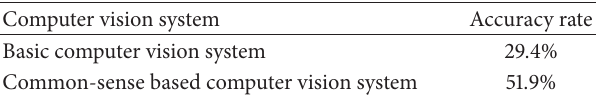
Table 1: Average of accuracy rates obtained by the basic and common-sense enhanced